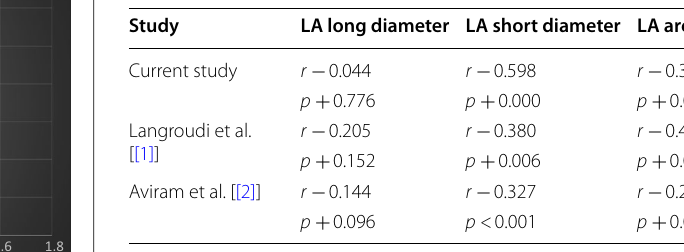
between the PAOI and radiologic